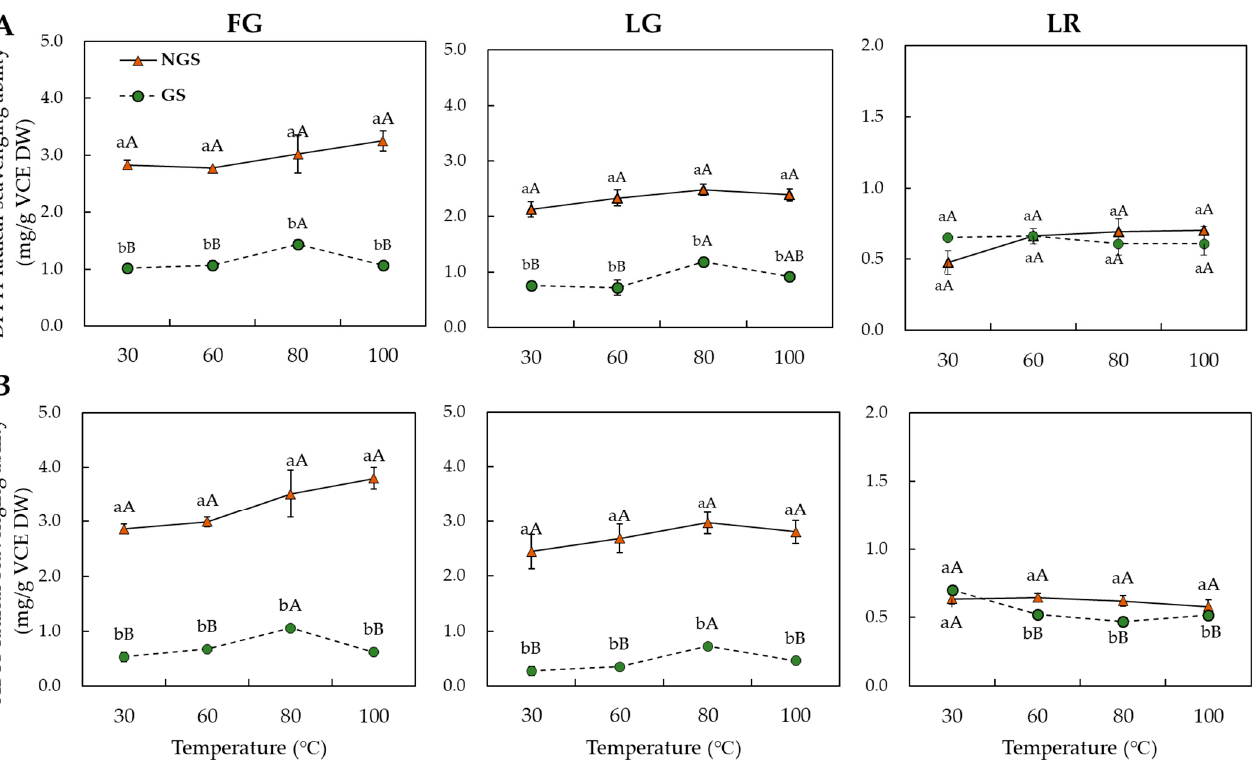
Figure 5. Changes in ( A ) DPPH, and ( B ) ABTS radical scavenging activities of different cultivars of lentil NGS and GS during thermal processing. Different lowercase letters indicate significant differences (Tukey’s studentized test at p < 0.05) between NGS and GS, and different capital let- ters indicate significant differences (Tukey’s studentized test at p < 0.05) between lentils treated at different temperatures.